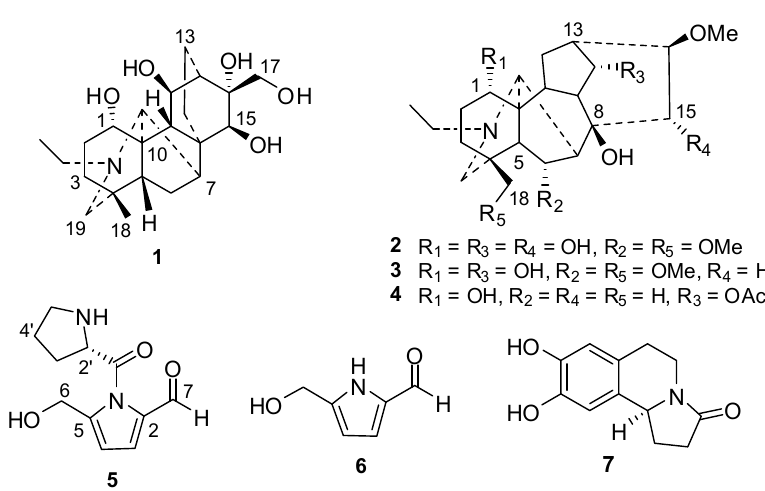
Figure 1. Structures of compounds 1 – 7